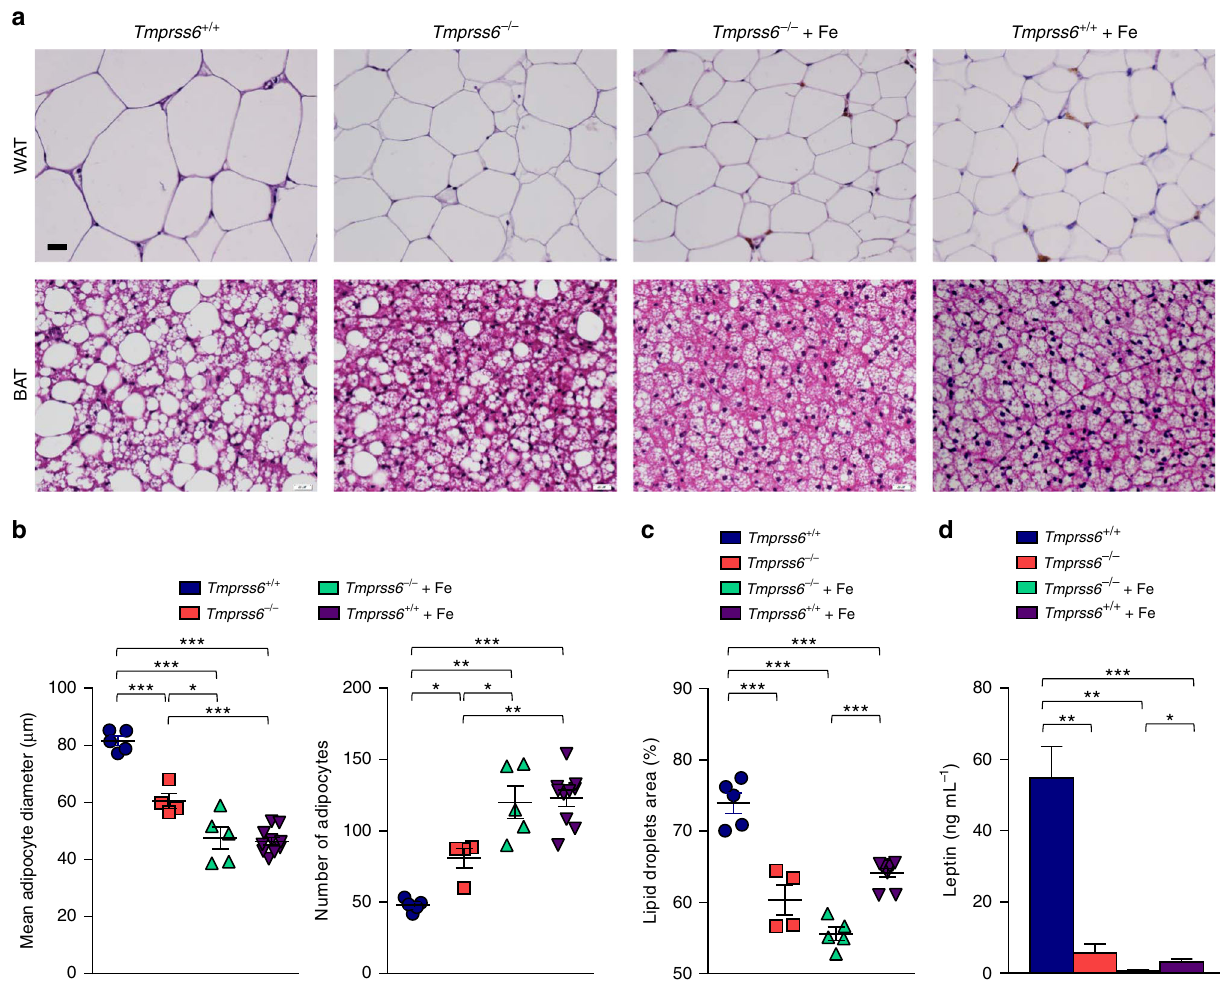
Fig. 2 Matriptase-2 de fi ciency prevents diet-induced adipocyte hypertrophy. a Representative images of epididymal fat pad and BAT sections stained with H&E from Tmprss6 + / + ( n = 5), Tmprss6 − / − ( n = 4), and both iron-treated Tmprss6 − / − and Tmprss6 + / + mice ( n = 5 and n = 9 – 10 respectively) fed a HFD for 20 weeks. b Size and number of epididymal adipocytes in Tmprss6 + / + ( n = 5), Tmprss6 − / − ( n = 4), and both iron-treated Tmprss6 − / − and Tmprss6 + / + mice ( n = 5 and n = 10, respectively). c Percentage of total area occupied by all lipid droplets in BAT sections stained with H&E in Tmprss6 + / + ( n = 5), Tmprss6 − / − ( n = 4), and both iron-treated Tmprss6 − / − and Tmprss6 + / + mice ( n = 5 and n = 9, respectively). d Fasting plasma concentration of leptin in Tmprss6 + / + ( n = 6), Tmprss6 − / − ( n = 6), and both iron-treated Tmprss6 − / − and Tmprss6 + / + mice ( n = 6 and n = 9, respectively) fed a HFD. Scale bar = 20 µ m. Data shown are mean ± SEM. * P < 0.05, ** P < 0.01, *** P < 0.001, two-tailed Student ’ s t test and Mann – Whitney